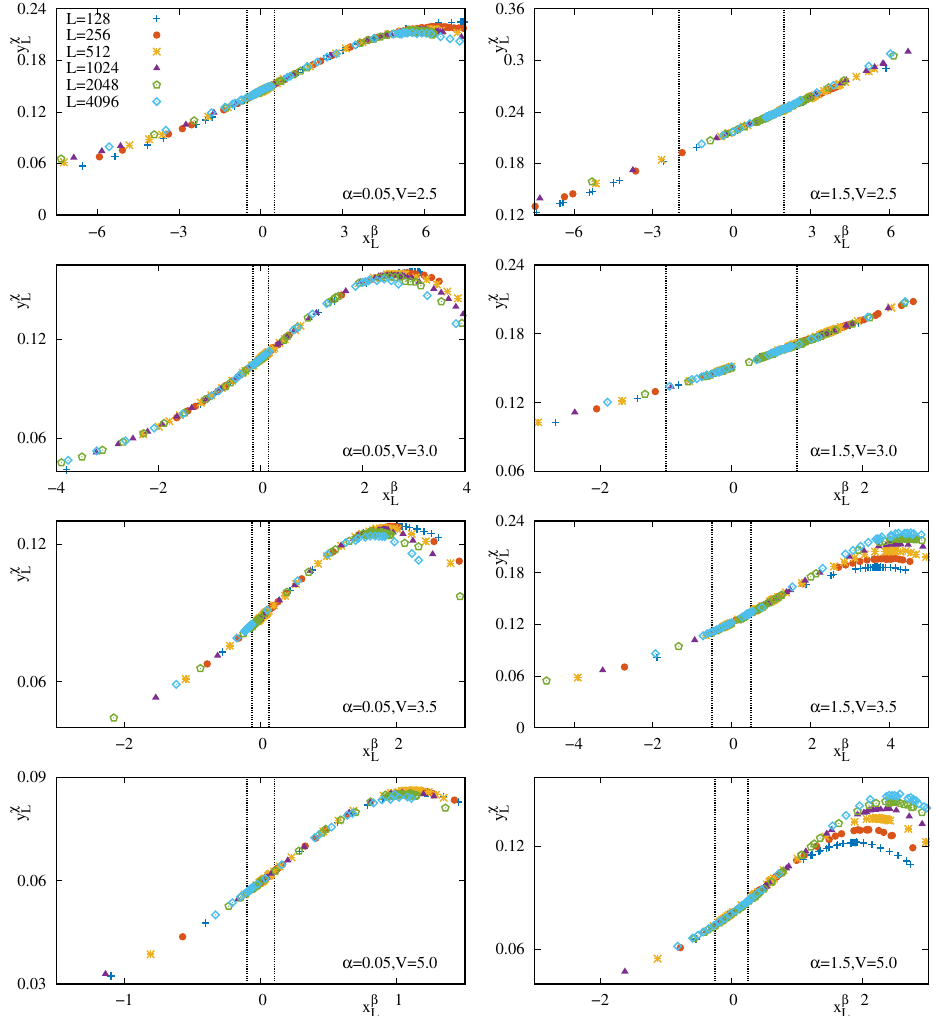
χ as a function of L β for the values of α and V studied in this work. The L β within which the data collapse scaling L